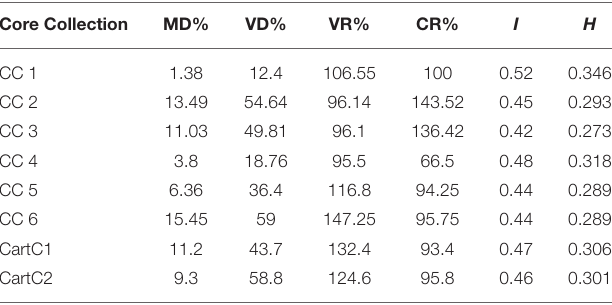
TABLE 6 | Evaluation indices for developed core collections. Core Collection